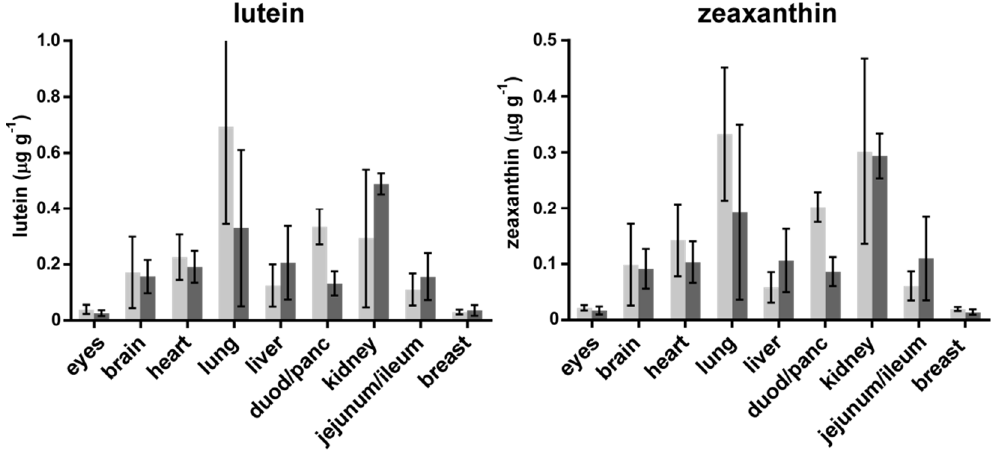
Figure 2. Lutein and zeaxanthin concentrations of the organs of chicken fed a standard diet (control group, light grey), and chickens fed an L and MZ ‐ enriched diet (active group, dark grey). Examples of the chromatography obtained during the analysis of the organs are presented in Figure 3.